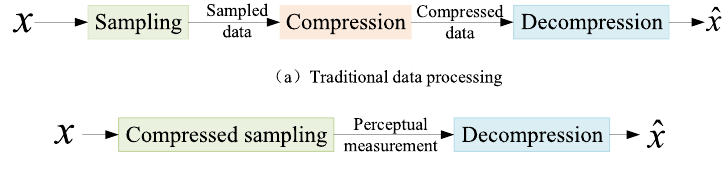
Fig. 7 Comparison of data compression and compression